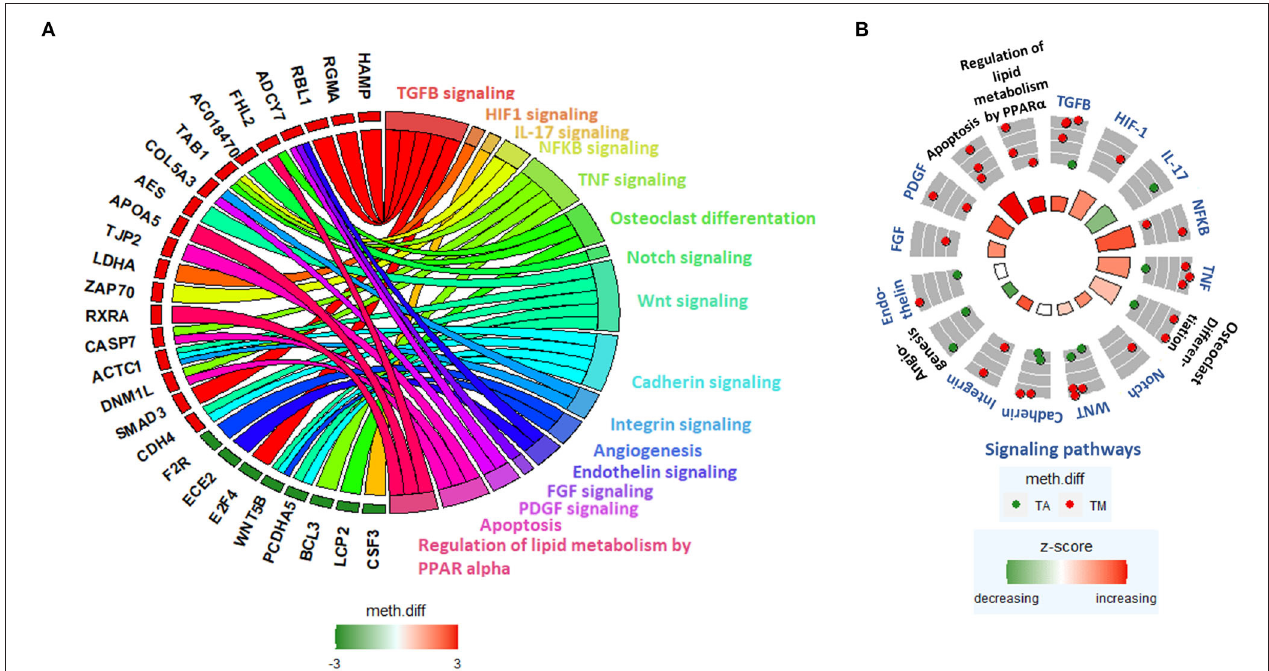
FIGURE 5 | (A) GOChord plot linking selected pathways to their constituent genes, which are associated with DM promoters. Green-to-red colors next to the selected genes reflect their meth.diff values. (B) GOCircle plot representing the relevant pathways and their constituent genes that are associated with DM promoters. The inner circle consists of bar plots, whose heights reflect the significance of the pathway and whose color reflect the z-score, which approximates the overall direction of change in methylation for each pathway. The outer circle shows scatterplots of the meth.diff values of each of the pathway’s constituent